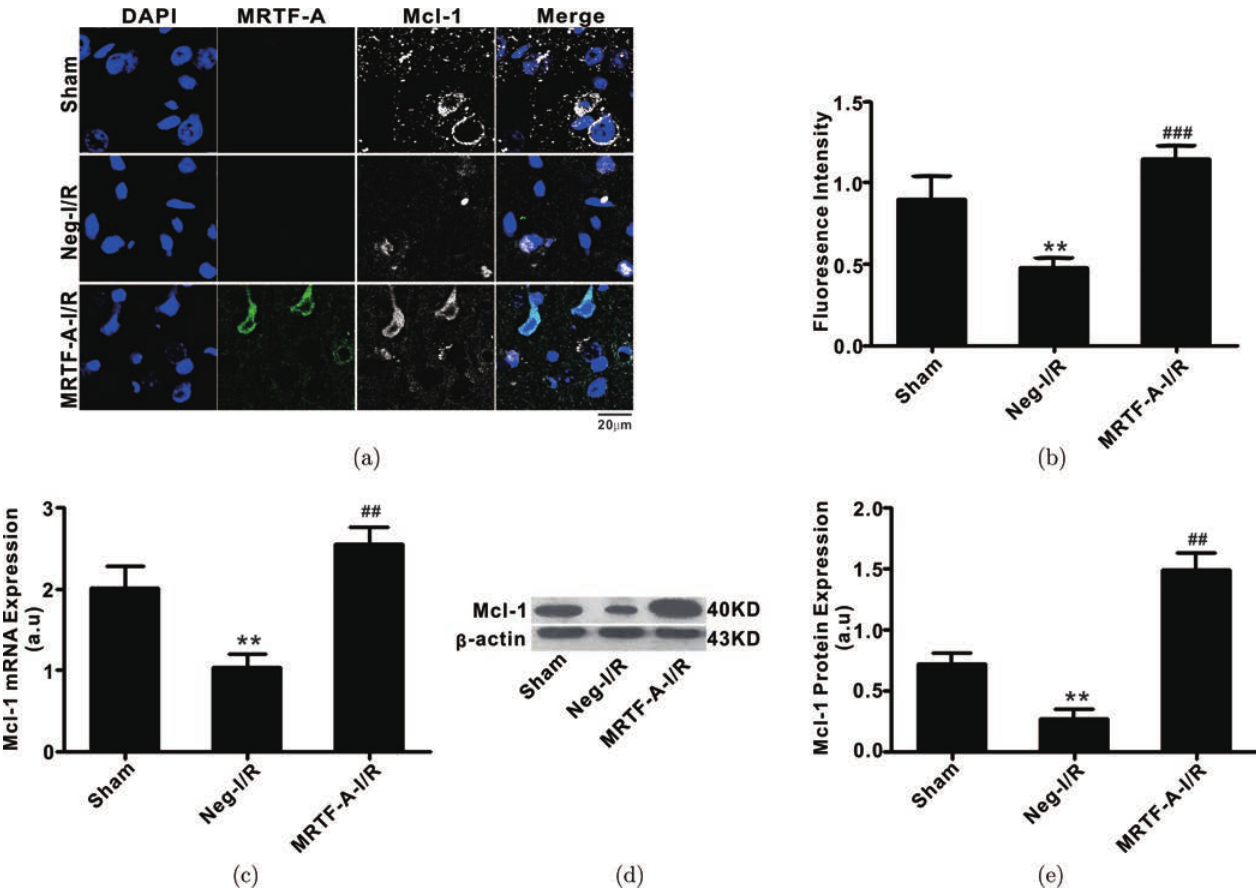
Fig. 3. E®ect of MRTF-A overexpression on myeloid cell leukemia 1 (Mcl-1) expression in rats with cerebral I/R injury. (a) Mcl-1 protein expression was analyzed using immuno°uorescence assay. (b) Quantitative analysis of Mcl-1 °uorescence intensity using Image J software. (c) Mcl-1 mRNA expression was analyzed using real-time PCR. (d) Mcl-1 protein expression was analyzed via western blot analysis. (e) Quantitative analysis of the Mcl-1 protein expression. * P < 0 : 05, ** P < 0 : 01 versus the sham group, # P